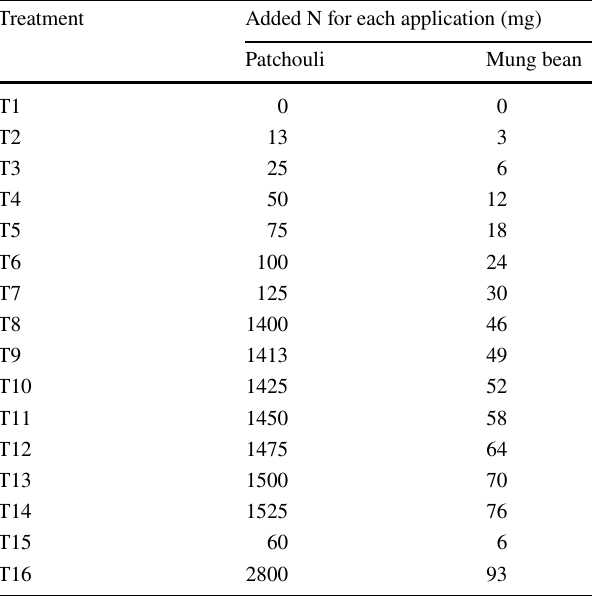
Table 8 Actual N added (in mg) per application Treatment Added N for each application